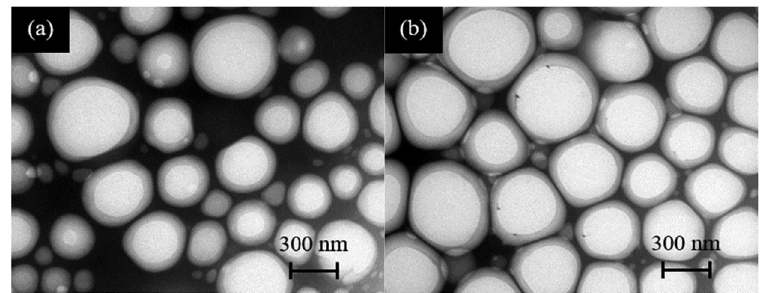
Figure 7: TEM photographs of BSA/AM microcapsules under di ff erent ultrasound modes: ( a ) continuous mode and ( b ) pulse mode.